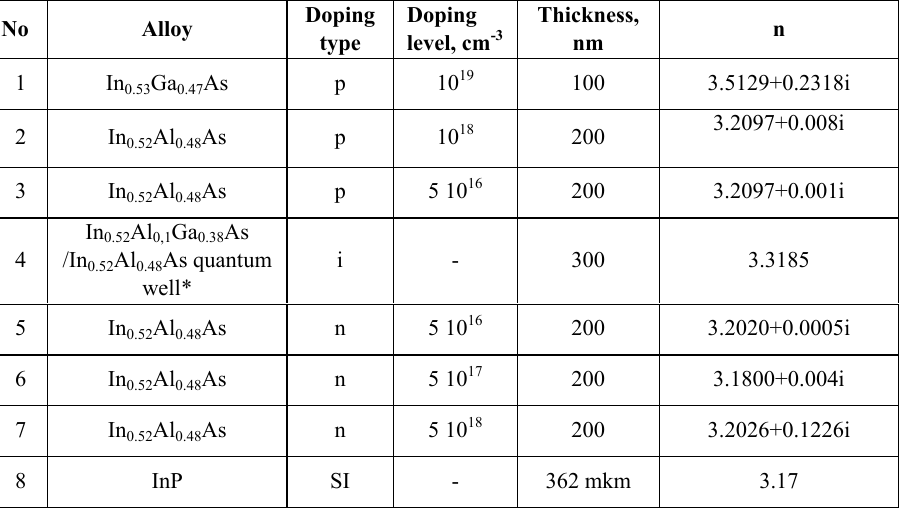
Table 1. Design of test